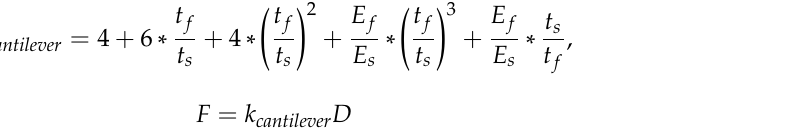
Figure 5. Magnetic force microscopy the deposited film.